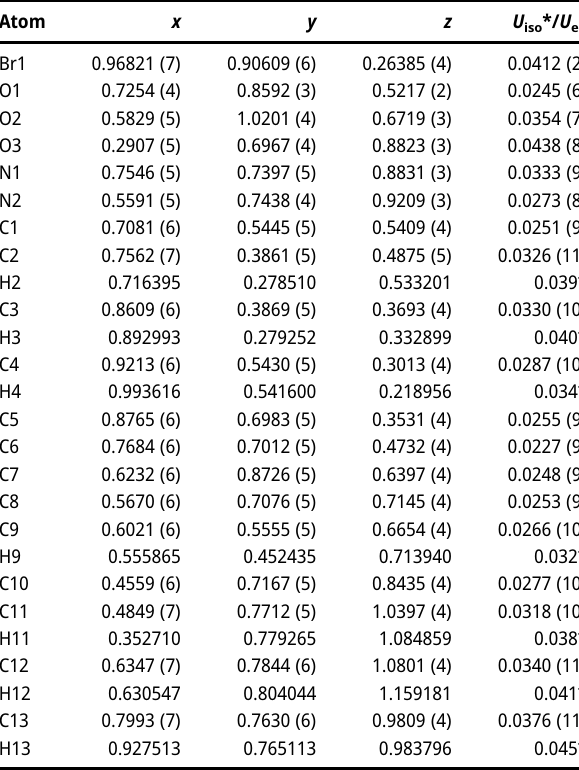
Table  : Fractional atomic coordinates and isotropic or equivalent isotropic displacement parameters (Å 